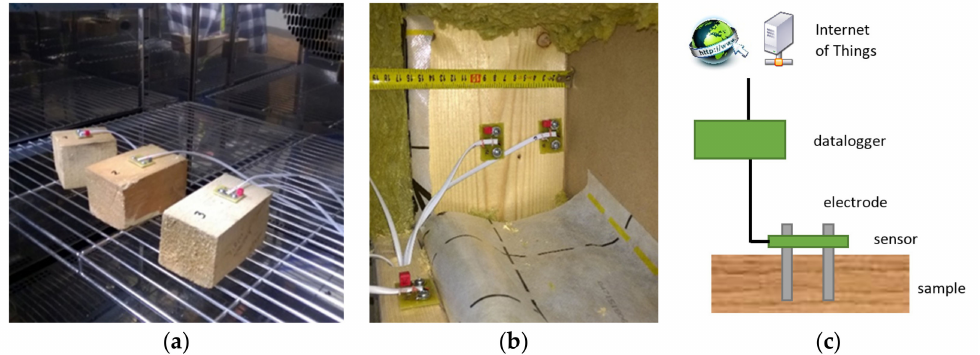
Figure 1. Implementation of small sensor module at real-world scale; ( a ) sensor testing in experimental chamber; ( b ) real wall structure integration; ( c ) functional